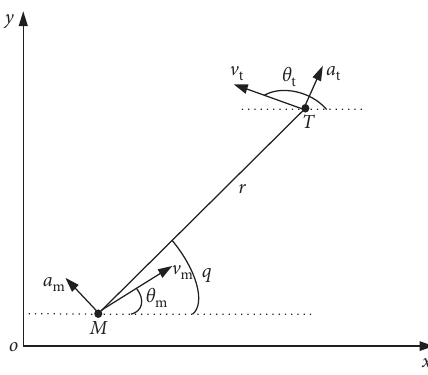
Figure 1: Relationship of missile-to-target